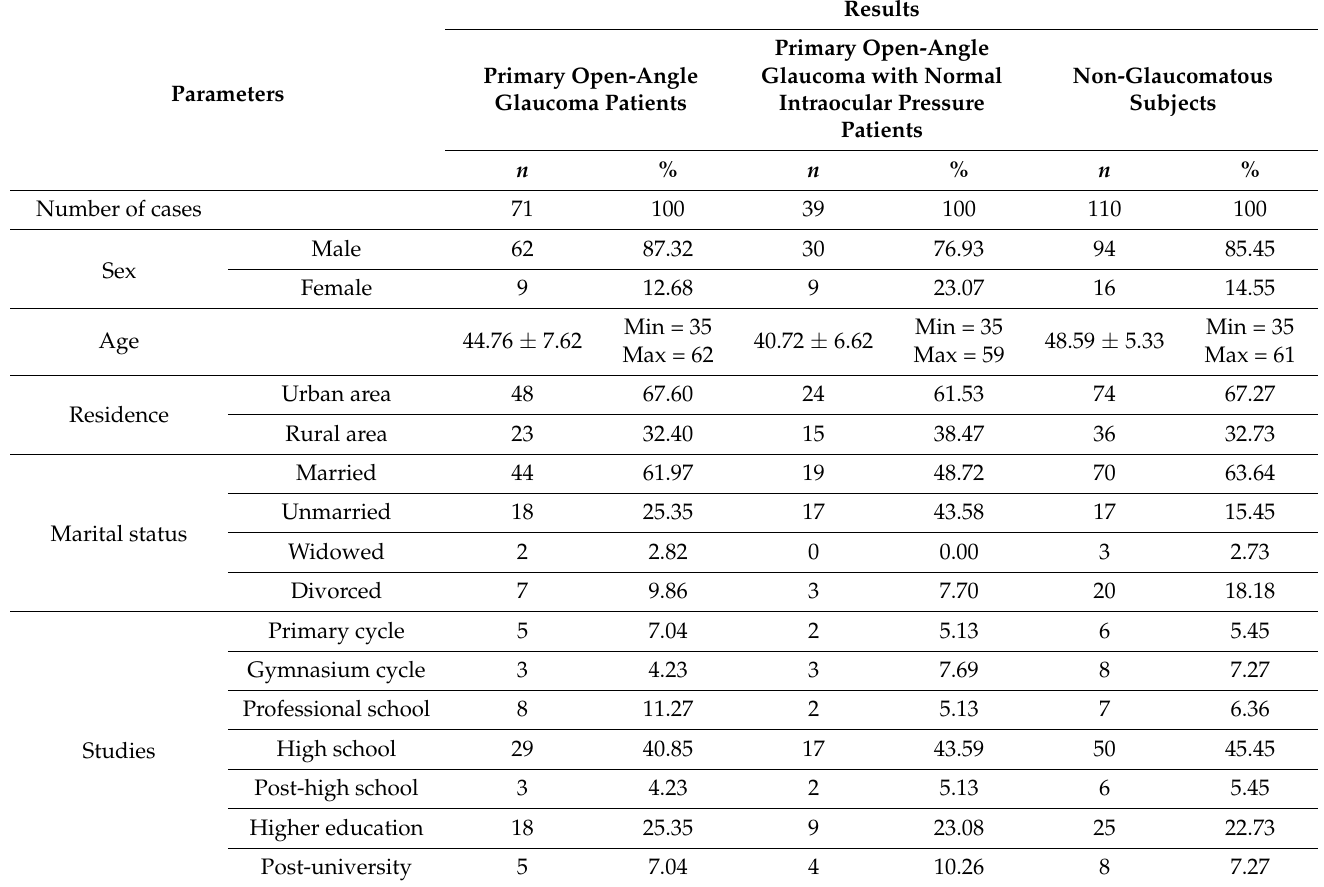
Table 2. Distribution of demographic indicators of